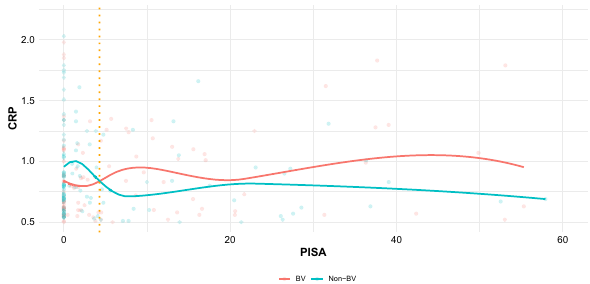
Figure 1. Comparison of C-reactive protein (CRP) (ng/mL) according to Periodontal Inflamed Surface Area (PISA) for women with and without BV.